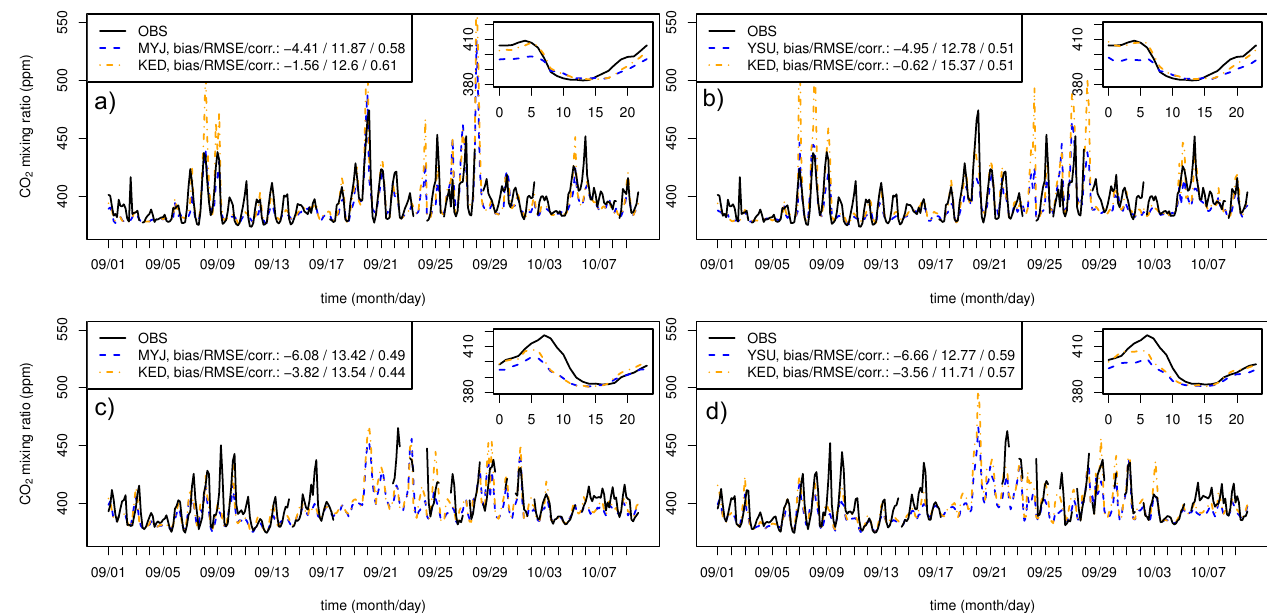
Figure 7. CO 2 time series observed at Cabauw 20ma.g.l. (a, b) and Heidelberg 30ma.g.l. ( c, d , black lines). STILT simulations are shown with (orange dash dotted lines) and without optimized MHs (blue dashed lines). Inlets in the upper right corner of each plot show the averaged diurnal cycle. In the upper left corner of each plot are summary statistics calculated for the full times series of the CO 2 mismatch: STILT observations together with STILT/observation squared correlation coefficient ( r 2 ). Data shown are 3h averages. Dates on the x axis refer to the analysis year